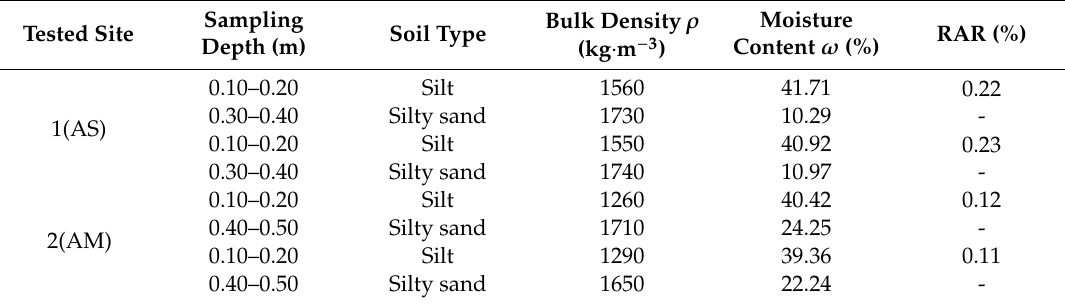
Table 2. The physical properties of the two vertical layers at both